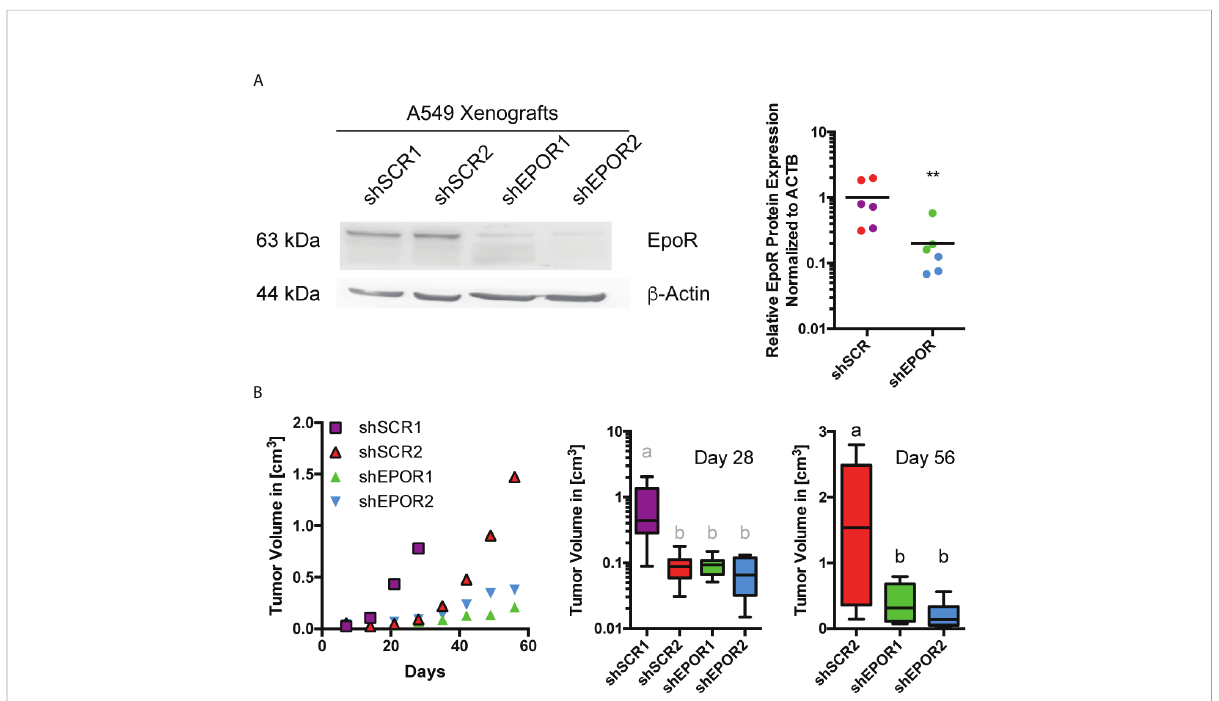
FIGURE 1 Knockdown of EPOR impairs tumor growth of A549 lung cancer xenografts in Foxn1nu mice. A549 control cells (shSCR1, purple and shSCR2, red) or A549 EPOR knockdown cells (shEPOR1, green and shEPOR2, blue) were subcutaneously injected (3 x 10 6 cells in 100 µl PBS/Matrigel) into Foxn1nu mice. Panel (A) shows a representative western blot image of EPOR (63 kDA) and b -actin (44 kDA) protein expression in shSCR and shEPOR A549 tumors (left panel). Western blotting images were analyzed by MCID Analysis 7.0 and shown is relative EPOR protein expression of shSCR (purple shSCR1 tumors, red shSCR2 tumors) and shEPOR (green shEPOR1 tumors, blue shEPOR2) tumors normalized to b - actin (n=6) (right panel). Panel (B) shows the tumor growth curves (left panel), tumor size 28 days after tumor cell implantation (middle panel), and tumor size 56 days after tumor cell implantation (right panel) for shSCR A549 and shEPOR tumors (n=8). Please note: The middle panel has a logarithmic scale, and in the right panel, no data for shSCR1 tumors are shown because the experiment was already terminated 28 days after tumor cell implantation. Data are presented either as scattered blots with mean, as mean, or as a box plot with min to max whiskers. A Student ’ s t-test (black symbols), a Kruskal Wallis test with Dunn ’ s multiple comparison test (grey letters), or a one-way ANOVA with Bonferroni post hoc test (black letters) was performed (**p<0.01); letters a and b indicate groups that statistically (p<0.05) differ from each